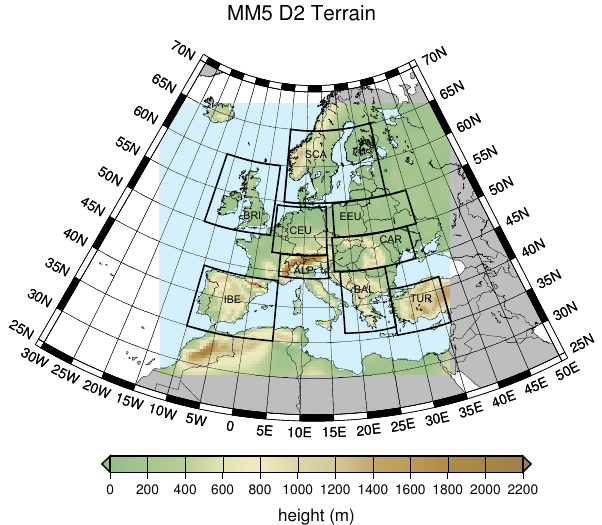
Fig. 2. Topography implemented in the inner domain of the MM5 simulation, with a spatial resolution of 45 km. The mother do- main covers a larger area with 135km of resolution (not shown). The figure illustrates the 9 subregions, selected according to geo- graphical considerations, used for more detailed analysis hereafter: IBE, Iberian Peninsula; BRI, British Isles; CEU, central Europe; EEU, eastern Europe; SCA, Scandinavian Peninsula and Baltic Sea; CAR, Carpathian Region; BAL, Balkan Peninsula; ALP, Alps; TUR, Turkey. The projection employed in this figure is the same as the one implemented in the RCM, Lambert Conformal, to illustrate as realistically as possible the domain setup. Note however that we use the Mercator projection in the figures hereafter to maximize the available space and facilitate the